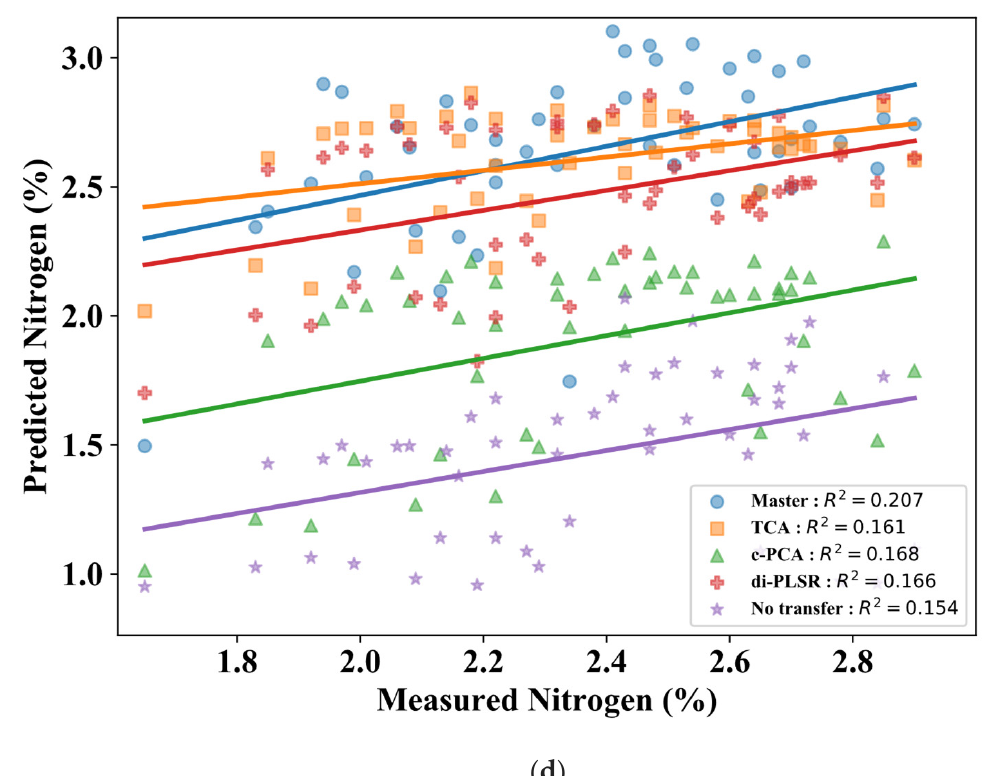
Figure 7. Measured and predicted nitrogen using TCA, c-PCA, and di-PLSR calibration transfer approaches: ( a ) slave–1 validation, ( b ) slave–2 validation, ( c ) slave–1 test, and ( d ) slave–2 test data. Predictions from master data are presented in blue circles, TCA in orange squares, c-PCA in green triangles, di-PLSR in red crosses, and no transfer in purple stars.